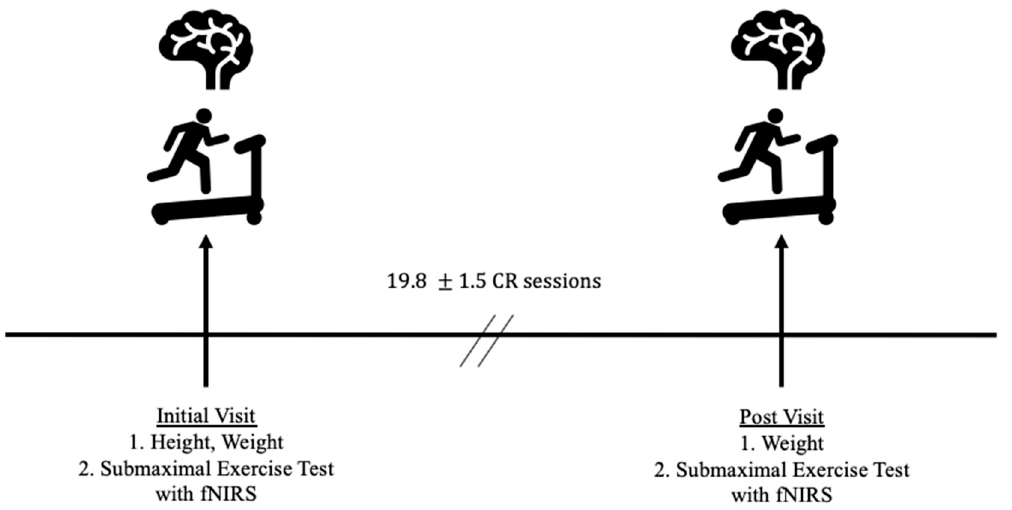
Figure 1. Outline of the study protocol. Number of cardiac rehabilitation (CR) sessions are mean ± SD. fNIRS = functional near infrared spectroscopy.